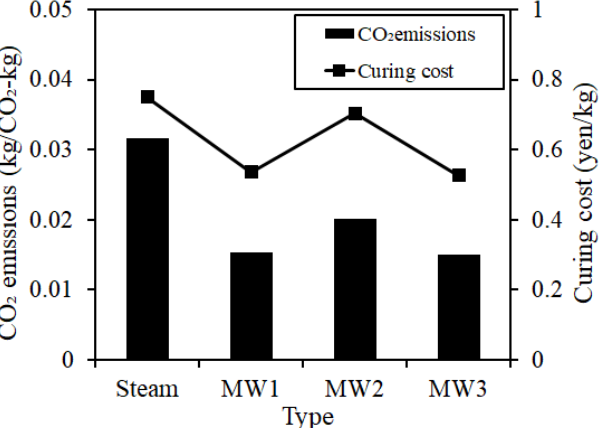
Figure 22. CO 2 emission and curing energy Figure 22. CO ₂ emission and curing energy cost.